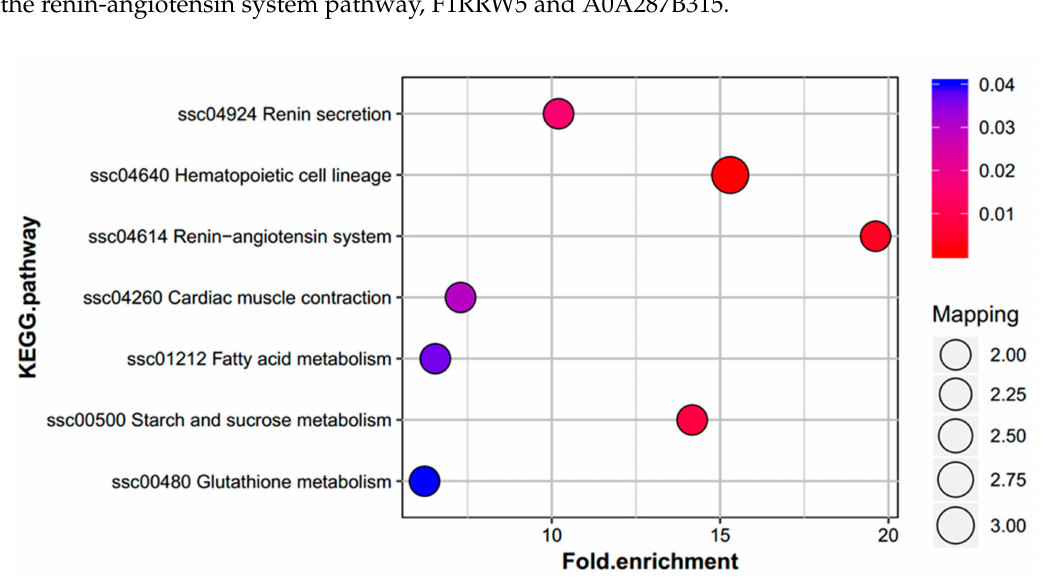
Figure 6. Kyoto Encyclopedia of Genes and Genomes (KEGG) pathway enrichment analysis of